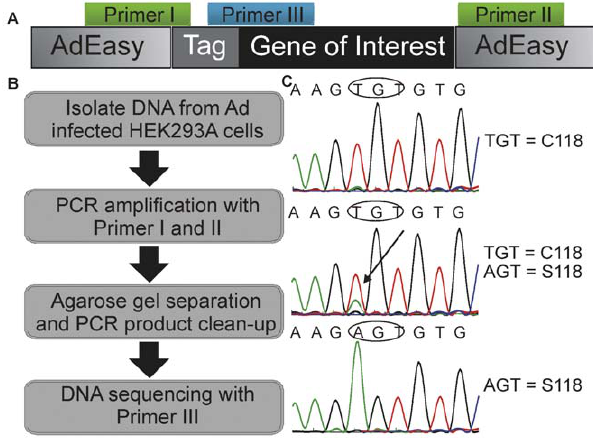
Figure 2. Contamination of Ad constructs during replication. (A) Primer locations for PCR of Ad and subsequent sequencing. Primer I and primer III ensure PCR of viral DNA by overlapping either with an affinity tag or part of the construct sequence. (B) Procedure used for sequencing Ad. (C) Sequencing results from early stage Ad amplification demonstrating contamination of the